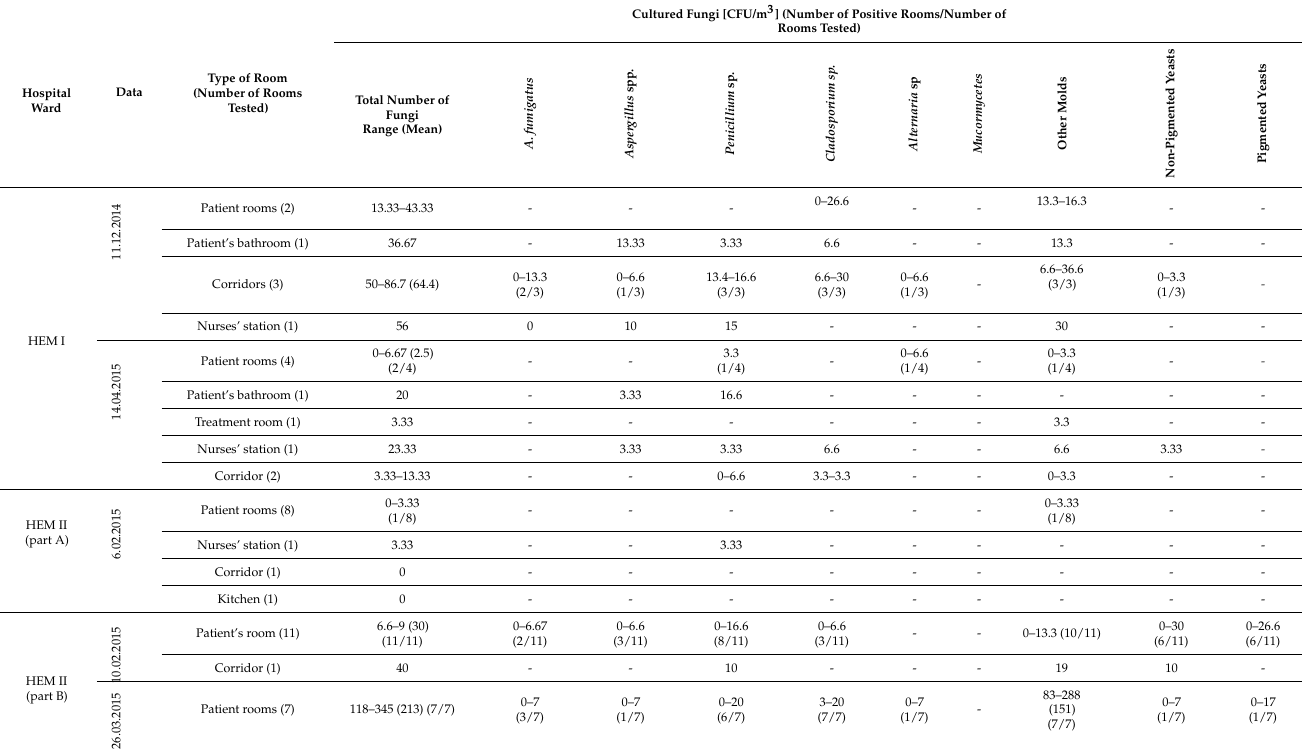
Table 1. Concentrations of fungi in the air of hematological